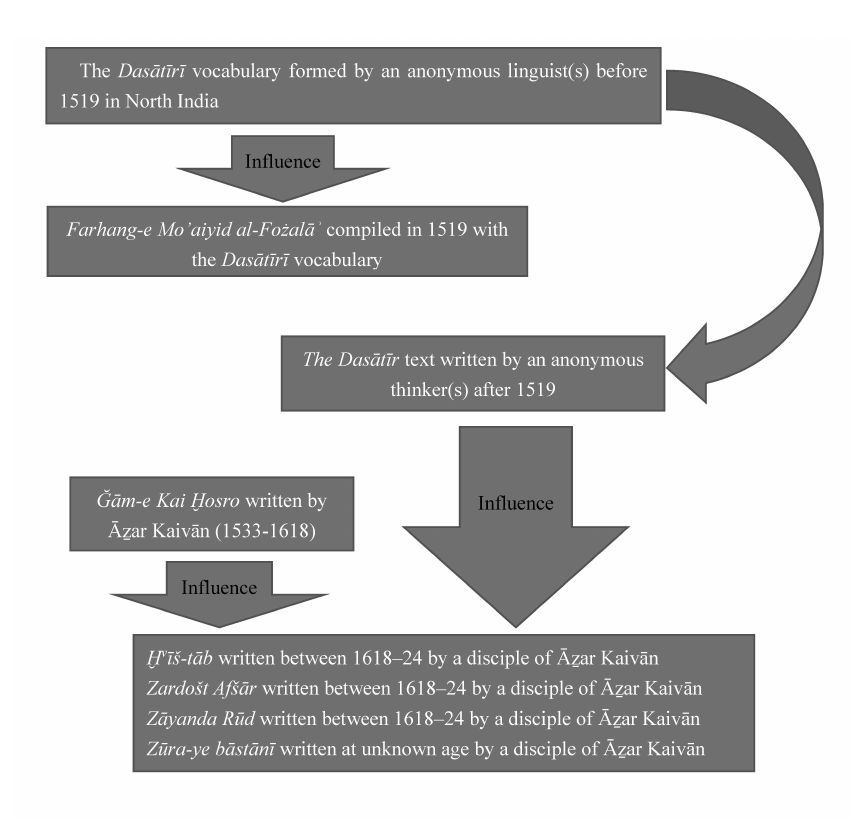
Figure 2 Proposed chronological order in which the extant texts of the Āẕar Kaivān School were